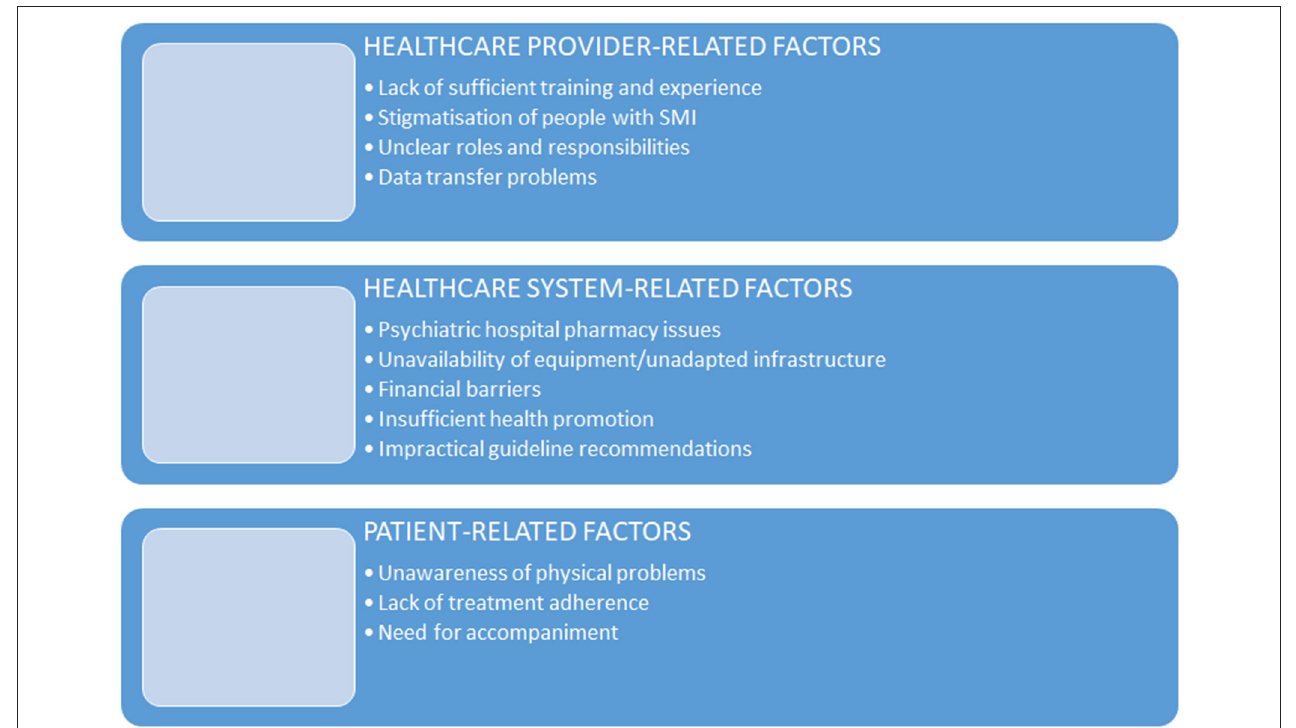
FIGURE 1 | Themes emerging from the qualitative